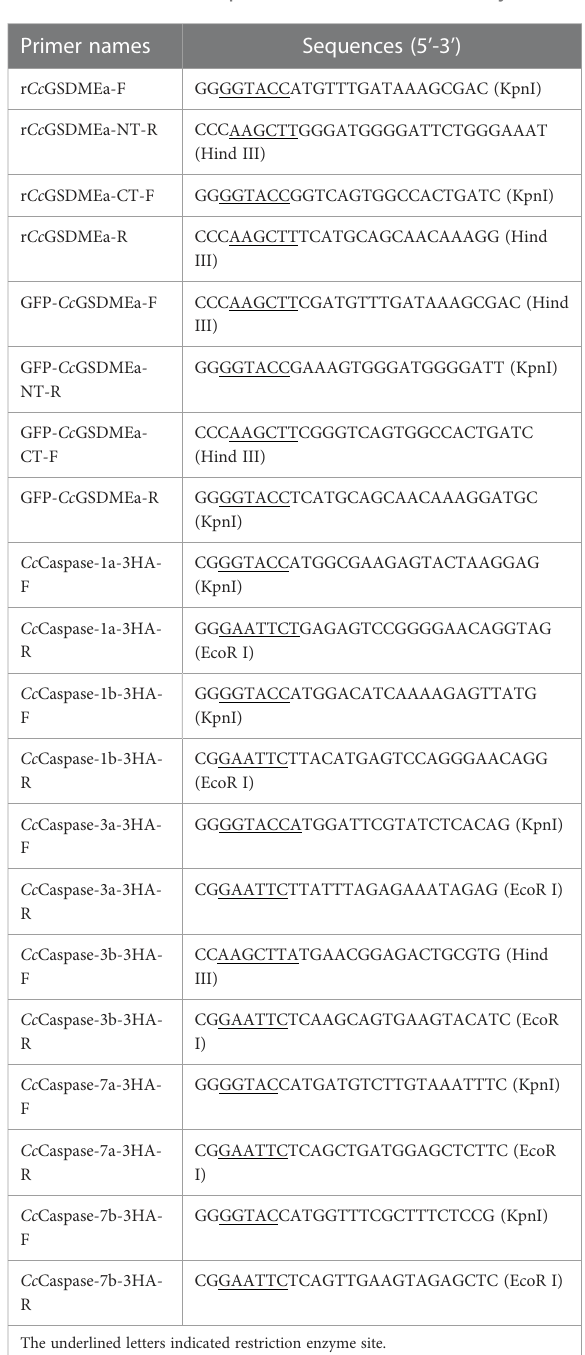
TABLE 2 Primers used for plasmid construction in this